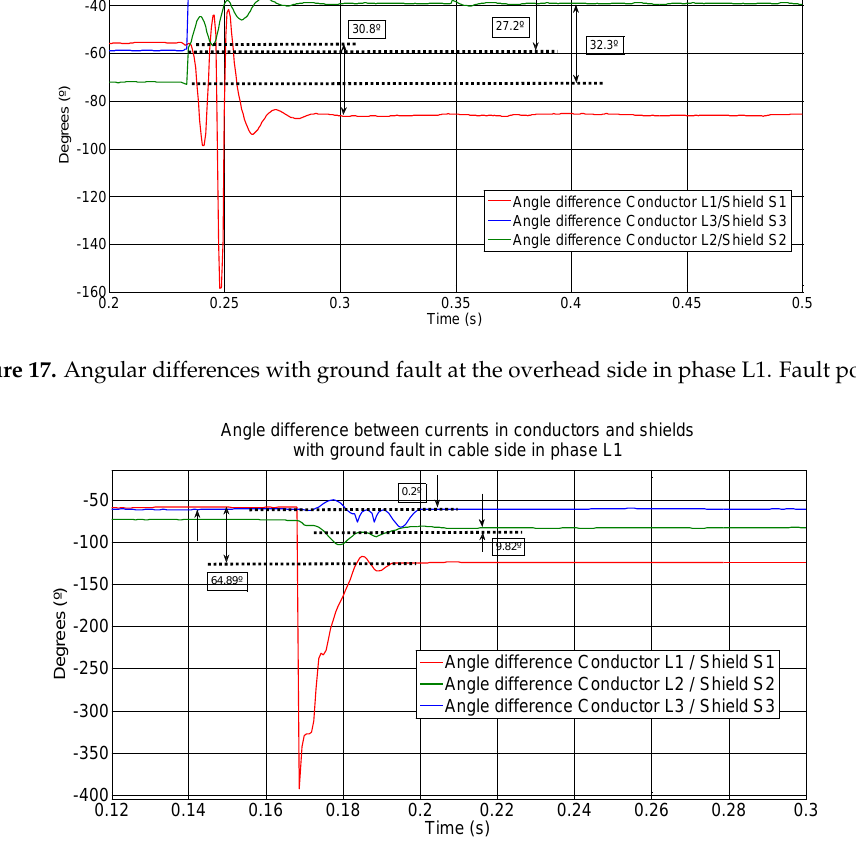
Figure 18. Angular differences with ground fault at the cable line side in phase L1. Fault point C.